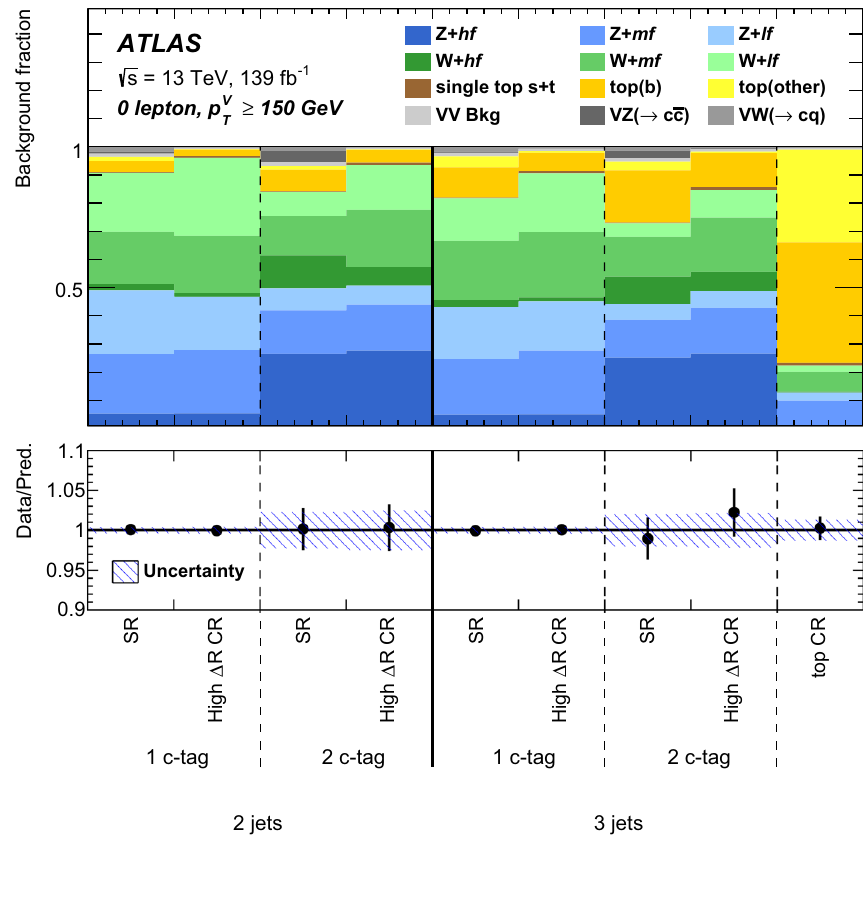
togram scaled to 300 times the SM prediction. The post-fit uncertainty is shown as the hatched background including correlations between uncertainties. The ratio of the data to the sum of the post-fit signal plus background is shown in the lower panel